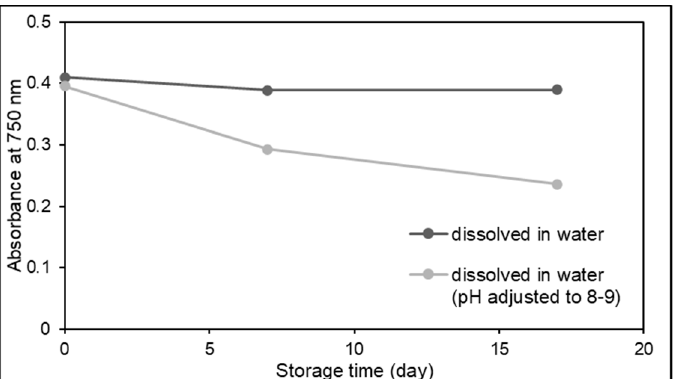
Figure A2. The variation of absorbance of polyphenols (Folin-Ciocalteau colorimetric method) from their solutions prepared in different media with storage time.